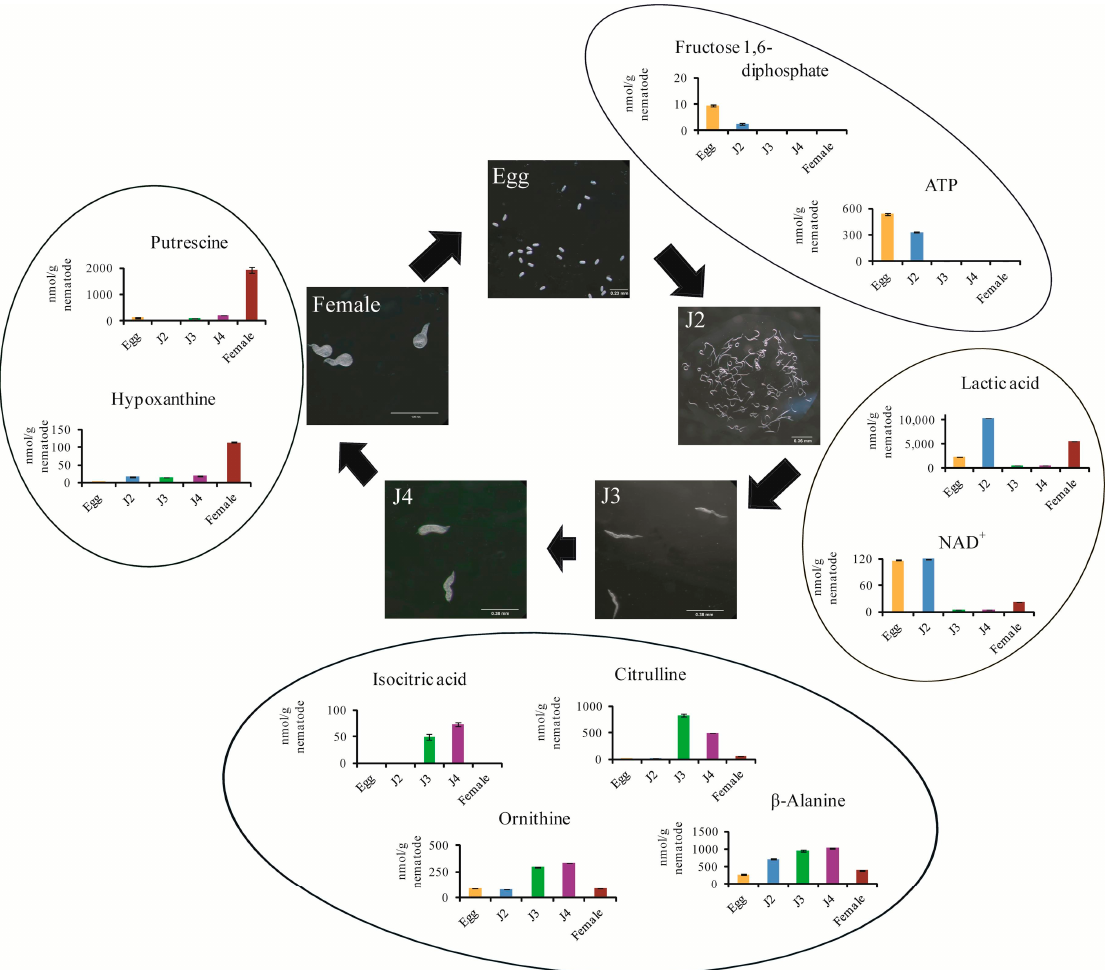
Figure 3. Morphology of the root-knot nematode Meloidogyne incognita at different stages of development and stage-specific highly expressed metabolites at each stage of the life cycle; ATP, adenosine triphosphate; NAD + , nicotinamide adenine dinucleotide. All metabolites concentrations were calculated by normalizing the peak area of each metabolite samples with respect to the area of the internal standard and by using standard curves, which were obtained by single-point (100 µM) calibrations. Scale bars in the representative stage images are egg (0.2 mm), J2 (0.4 mm), J3 (0.4 mm), J4 (0.4 mm) and female (1.0 mm).